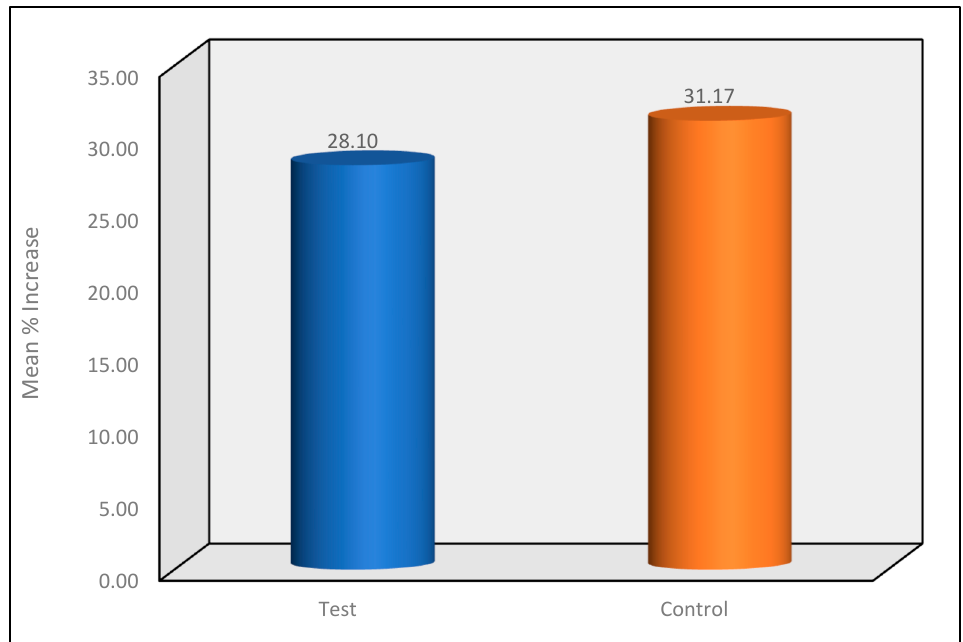
Figure 6. Mean percentage increase in VAS between the two groups at the T1 Time Interval.